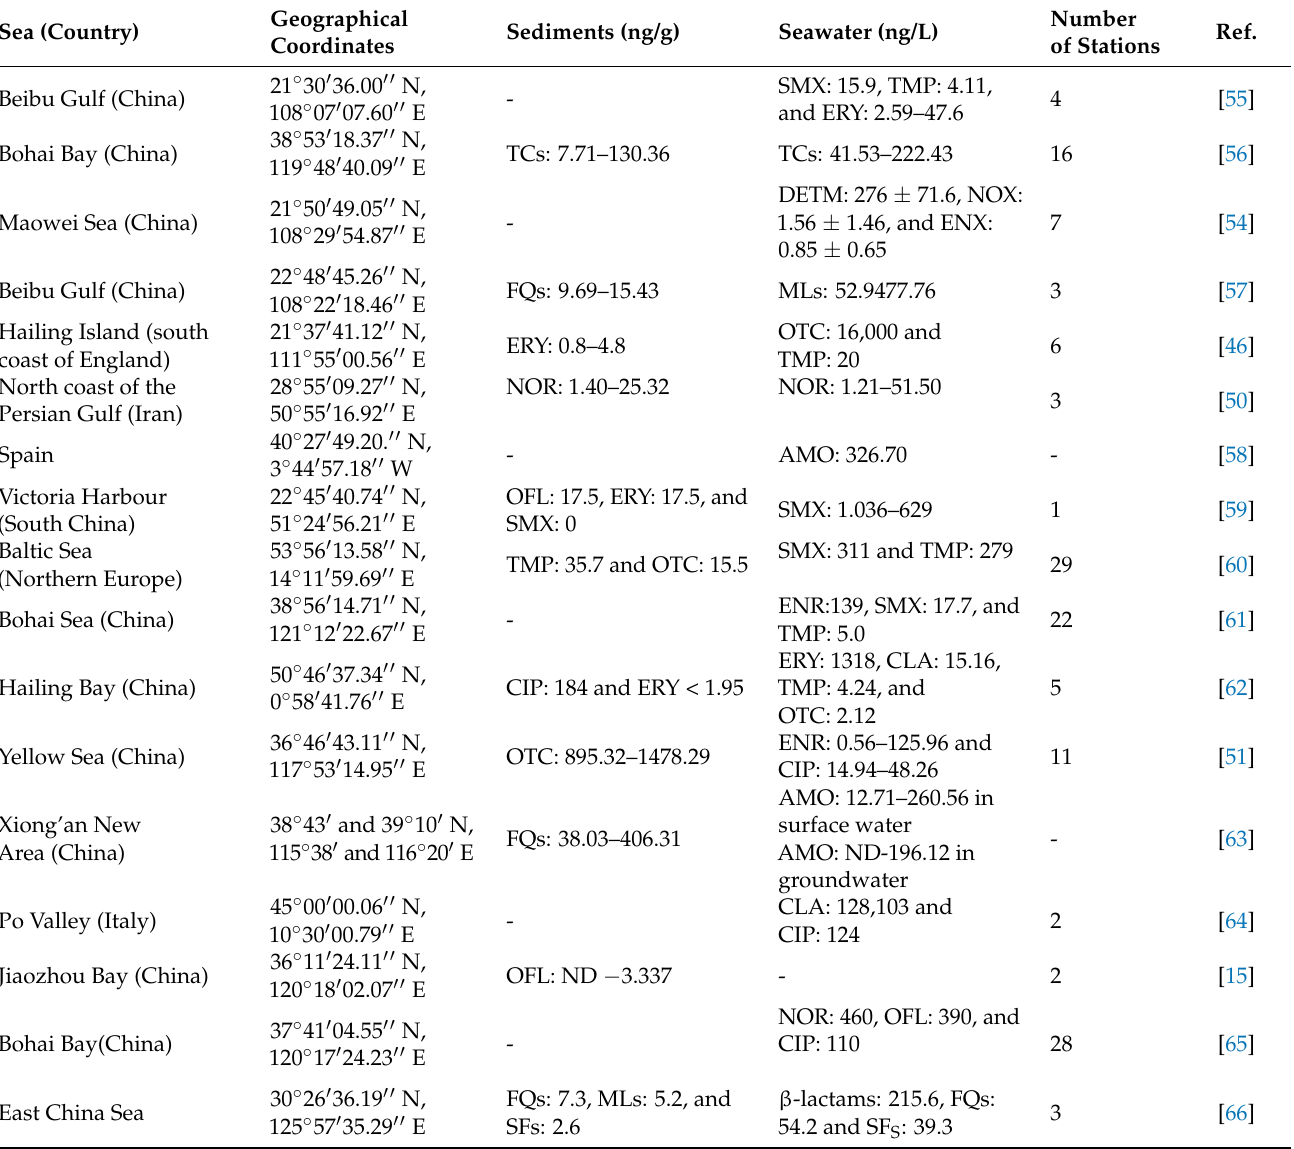
Table 2. Studies on antibiotics in seawater and sediments in marine environments around the